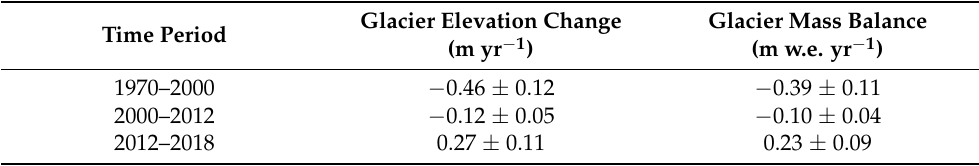
Figure 2. Observed surface elevation changes (m yr − 1 ) over the Chongce Glacier during the periods of 1970–2000 ( a ), 2000– 2012 ( b ), and 2012–2018 ( c ). Note that the coverage of the ZY-3 images (see Figure 1) resulted in the data missing in the southwest part ( c ). Table 2. Estimated average glacier elevation change and glacier mass balance between 1970 and 2018 over the Chongce Glacier.